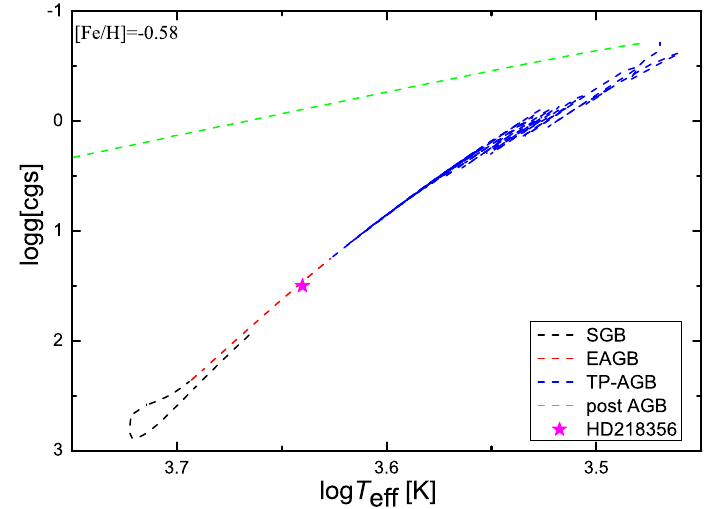
Figure 6. The stellar evolutionary track of a star with 2.1 M (cid:12) and [Fe/H] = − 0.58dex calculated using the MIST model. The evolution phases from the SGB to post-AGB are presented. The filled red asterisk represents the Ba giant HD218356.